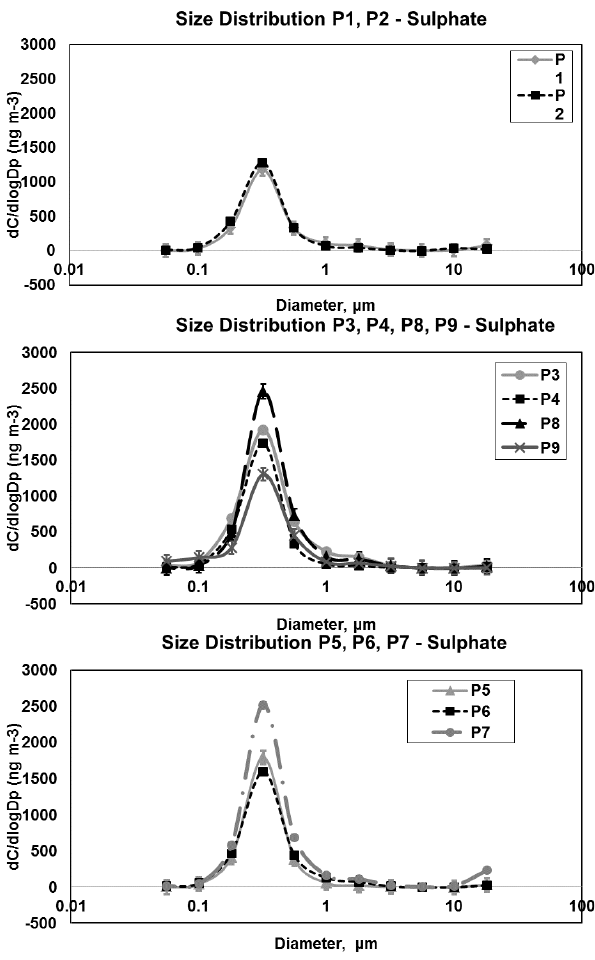
Fig. 4. Normalized size-segregated mass distribution of SO 2 − ing the sampling periods P1–P9 listed in Table 1.